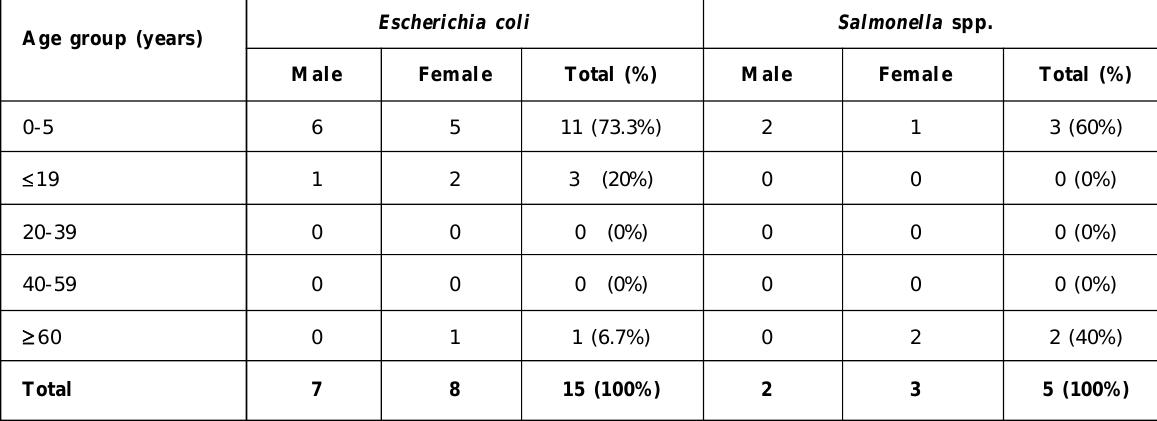
Table 2: Distribution of isolated bacterial among the study population ( n = 51) Bacteria No. of Escherichia coli